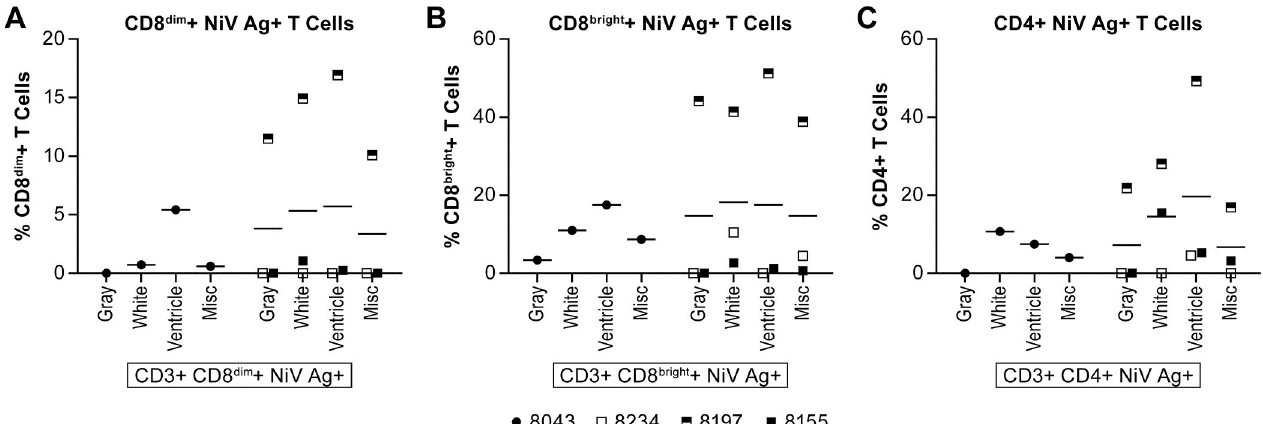
Fig 12. Nipah virus antigen positive T cells in the brain. Tissues were collected as described in the legend for Fig 10. Animals included in this analysis included 8043 (filled circle), 8234 (open square), 8197 (half filled square) and 8155 (filled square). Detection of intracellular antigen was achieved using a NiV GP reactive polyclonal antisera generated in rabbits. Analyses included (A) NiV antigen+ CD8 dim T cells; (B) NiV antigen+ CD8 bright T cells; and (C) NiV antigen+ CD4+ T cells. The solid lines represent the mean for that dose